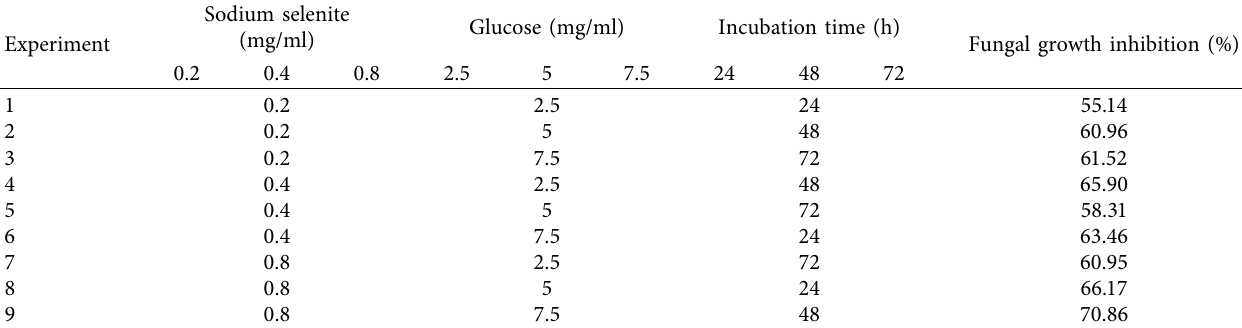
Table 1: Taguchi design of experiments and fungal growth inhibition rate of selenium synthesized nanoparticles.